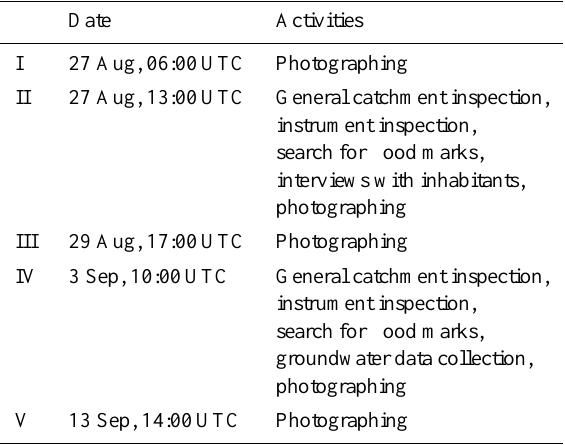
Table 1. Overview of the post-event field surveys (photos in Fig. 8).